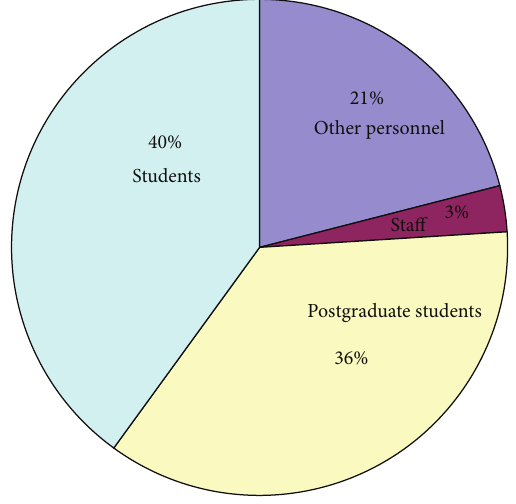
Figure 1: Percentage of accidents by operator